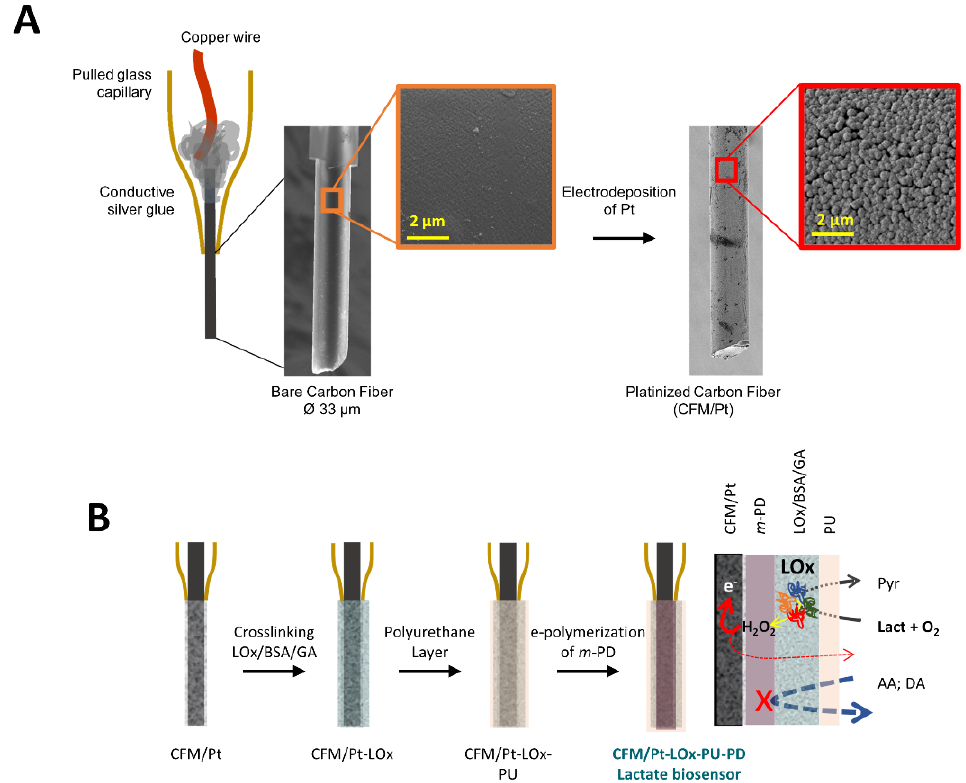
Figure 1. ( A ) Schematic representation of a CFM, showing a scanning electron microscopy (SEM) micrograph of the carbon tip before and after platinization. The blow-up image on the far right shows the surface morphology of the Pt particles on the carbon fiber. ( B ) CFM/Pt-LOx-PU-PD microbiosensor design stages. Starting on the left with a CFM/Pt on which LOx is immobilized by cross-linking with glutaraldehyde in a BSA matrix. The sensor is then coated with a polyurethane layer. In the final step, a permselective membrane of m -PD is electropolymerized on the active surface. On the far right is the scheme of microelectrode operation. LOx—lactate oxidase, GA—glutar- aldehyde, PU—polyurethane, Lact—lactate, Pyr—pyruvate, AA—ascorbic acid, DA—dopamine.